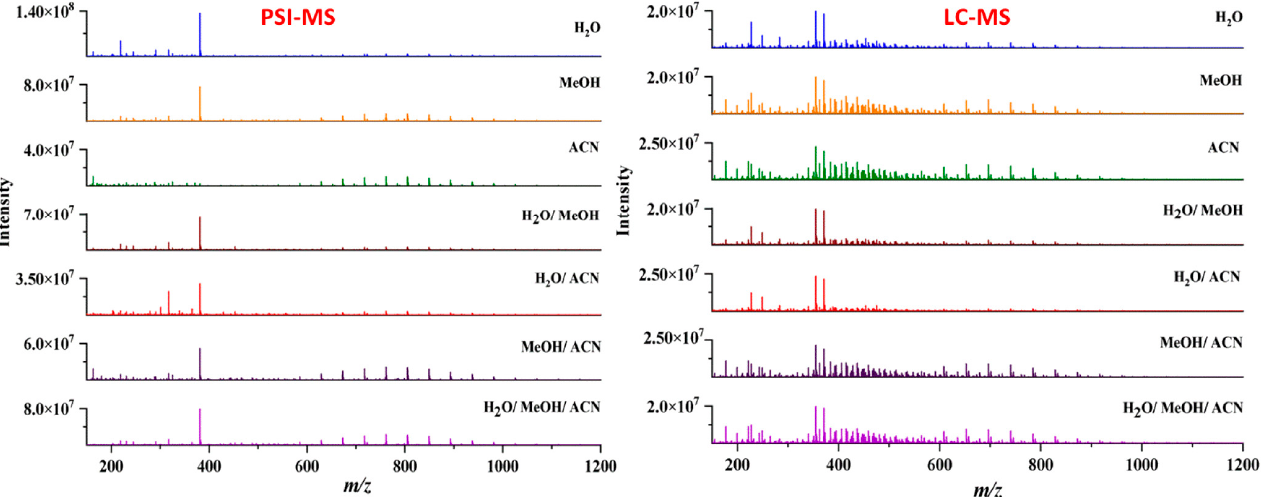
Figure 3. Comparison of chemical profiles obtained by paper spray ionization–mass spectrometry (PSI-MS) and liquid chromatography–mass spectrometry (LC-MS) for the different extraction sol- vents.